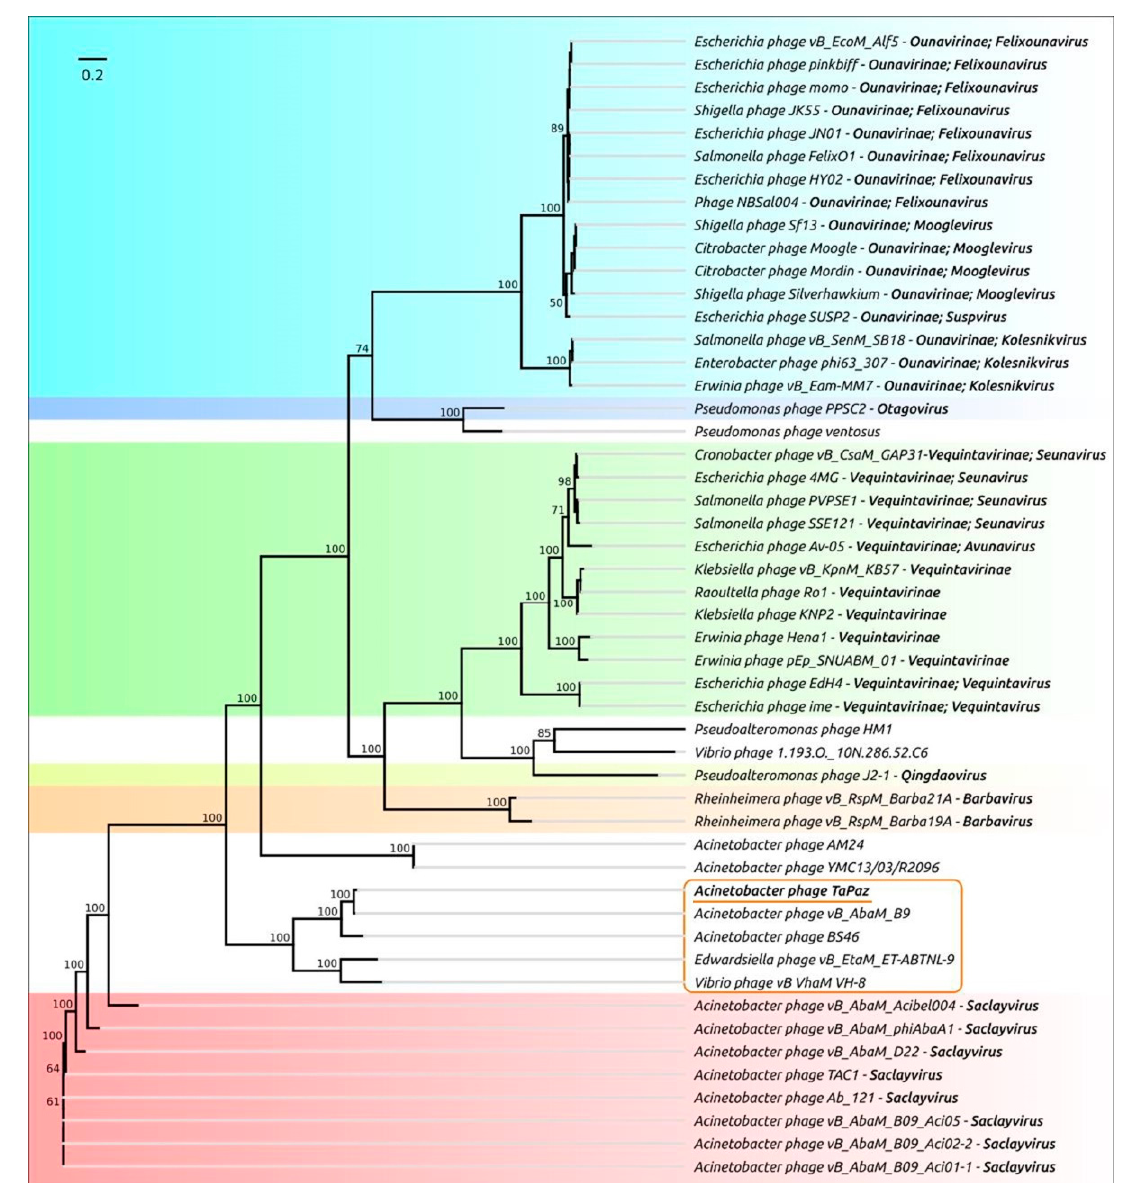
Figure 4. Best-scoring phylogenetic tree based on concatenated sequences of a major capsid protein, a large subunit of terminase, a portal protein and a tail tape measure protein from the genomes of 50 phages. Taxonomic classification is taken from ICTV (International Committee on Taxonomy of Viruses) and NCBI sequence attributes and is shown to the right of the organism’s name. Bootstrap support values are shown near their branch as a percentage of 1000 replicates. The scale bar shows 0.2 estimated substitutions per site and the tree was unrooted.